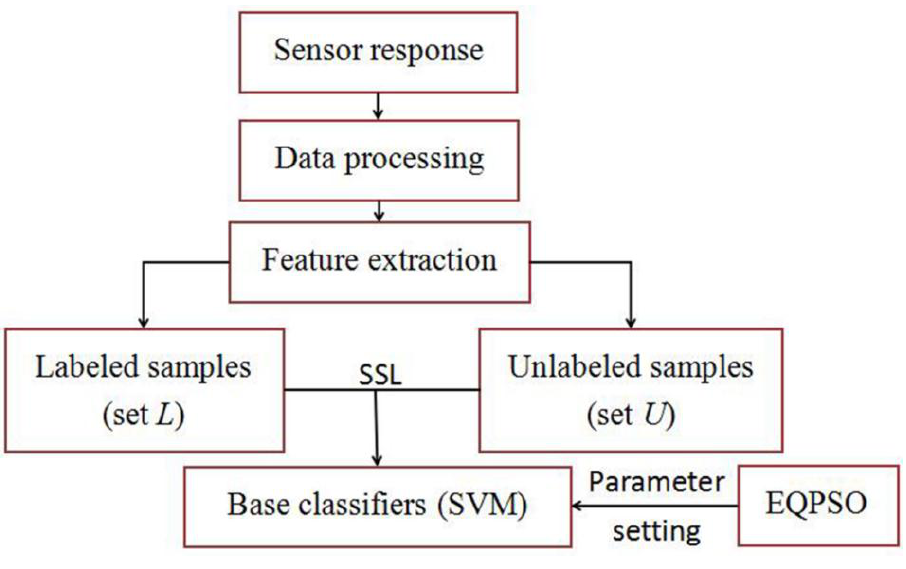
Figure 4. Flow chart of SSL process.